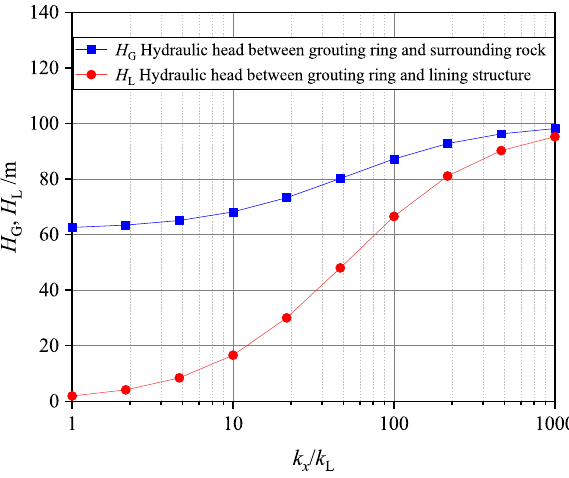
Figure 8. Seepage discharge under different total hydraulic head at infinite distance.